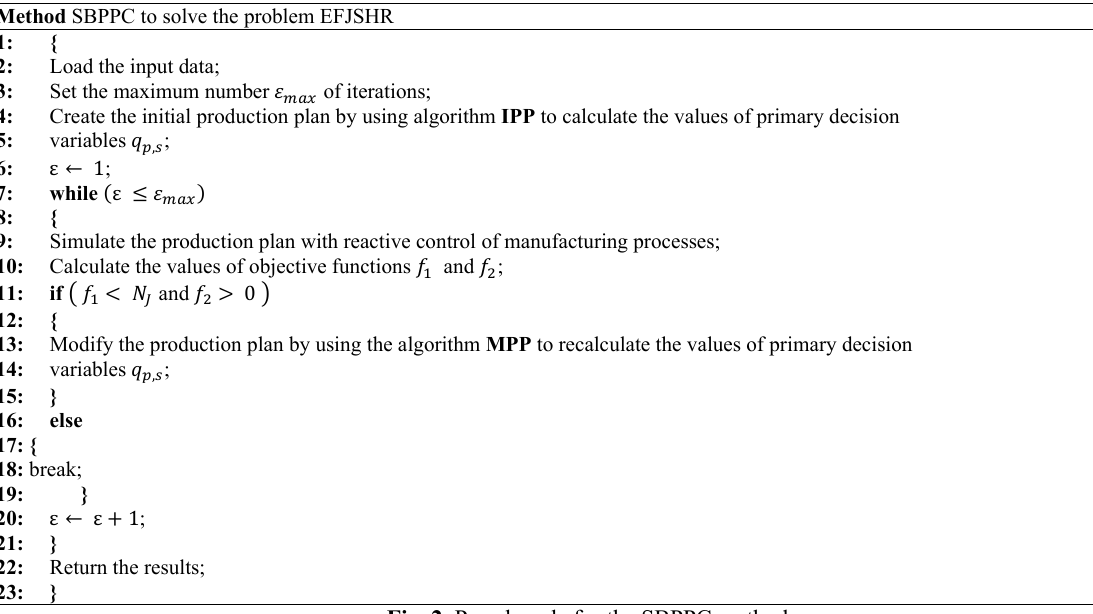
Fig. 2. Pseudocode for the SBPPC